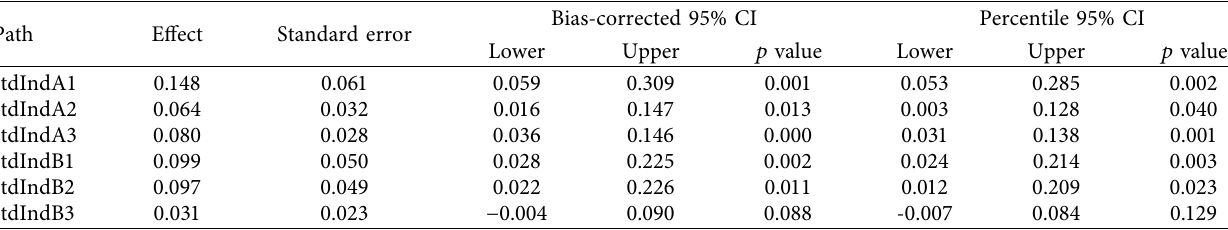
Figure 2: Results of our model. Note: ∗∗∗ , ∗∗ , and ∗ represent p < 0.001, p < 0.01, and p < 0.1, respectively; ns means the influence is Table 8: Mediating effect test results of standardized bootstrapping.